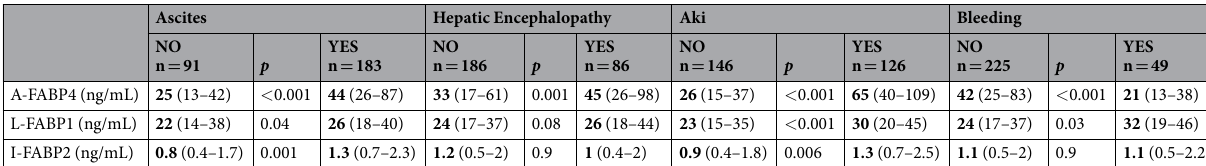
Table 2. Plasma levels of FABPs according to the presence or absence of complications of cirrhosis at inclusion. FABPs levels are expressed as median (inter-quartile range). A-FABP4: adipocyte fatty-acid binding protein